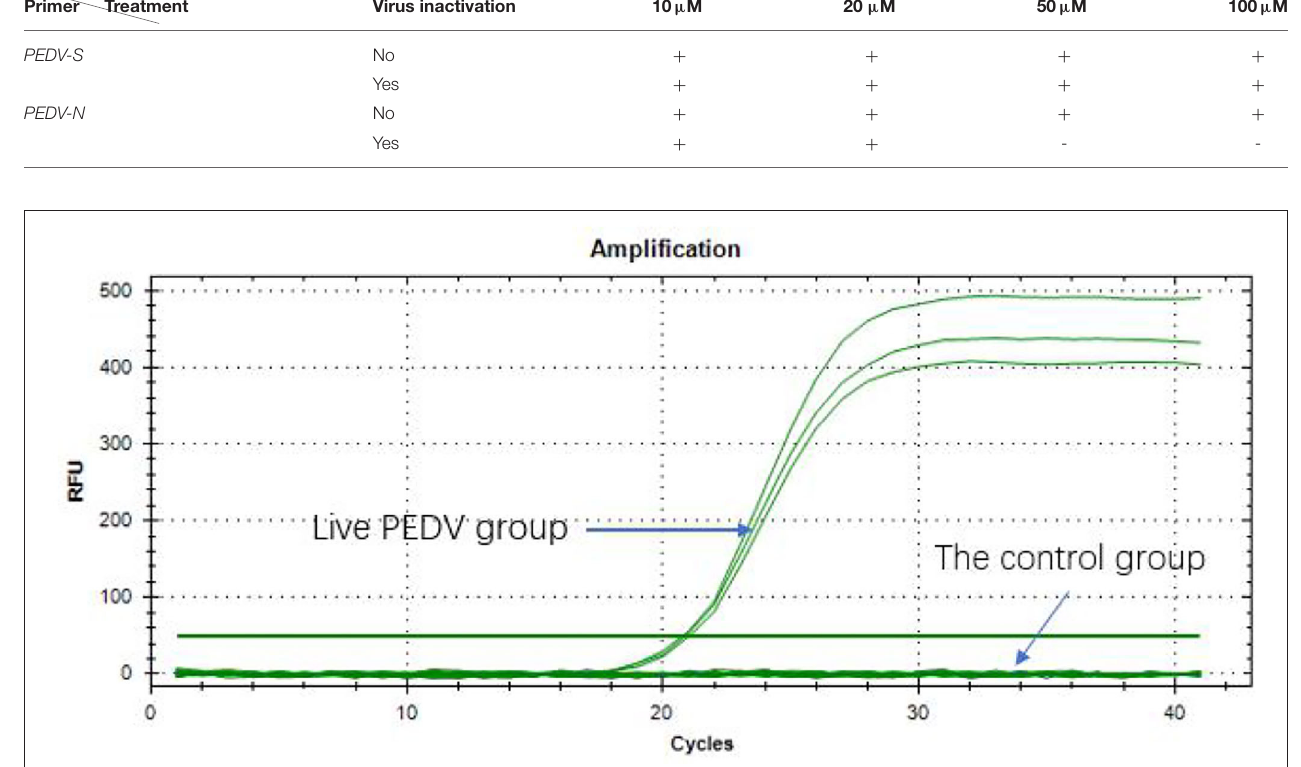
FIGURE 3 | Specificity of primers.